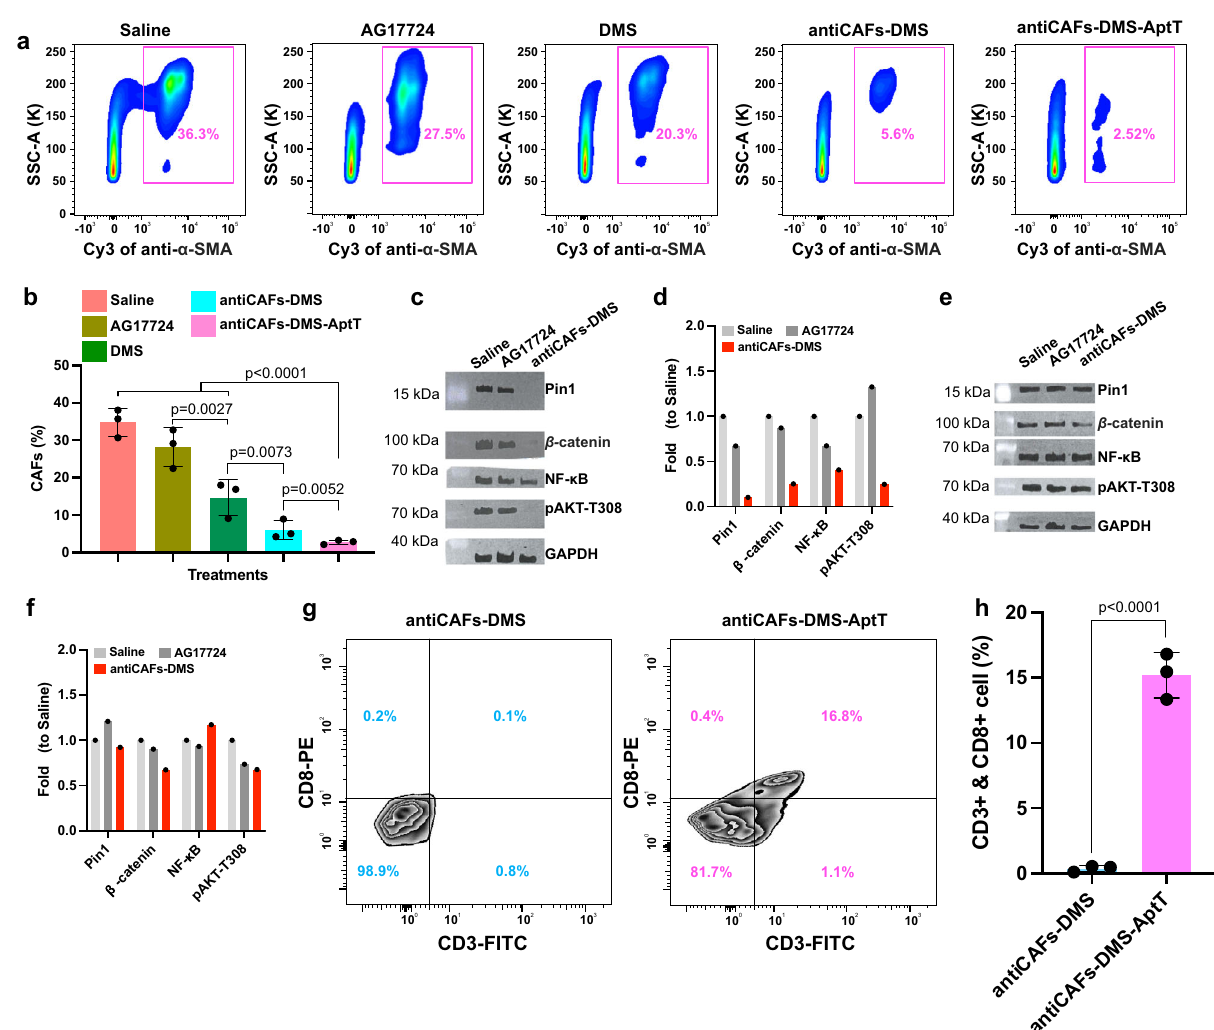
Fig. 6 | Tumor tissue analysis on CAFs, Pin1, and T lymphocytes. a , b Quantitative analysis, via cell sorting and counting, of CAFs in tumors from mice receiving different treatments ( n =3 biologically independent animals; error bars, mean±SD). One way analysis of variance followed by Turkey posttests. c Western blotting detection of Pin1 and relative proteins in sorted CAFs from tumors collected from mice treated with saline, AG17724 or antiCAFs-DMS. d Quantitative analysis of the western blotting results of sorted CAFs (Three independent repetitions got similar results.). e Western blotting detection of Pin1